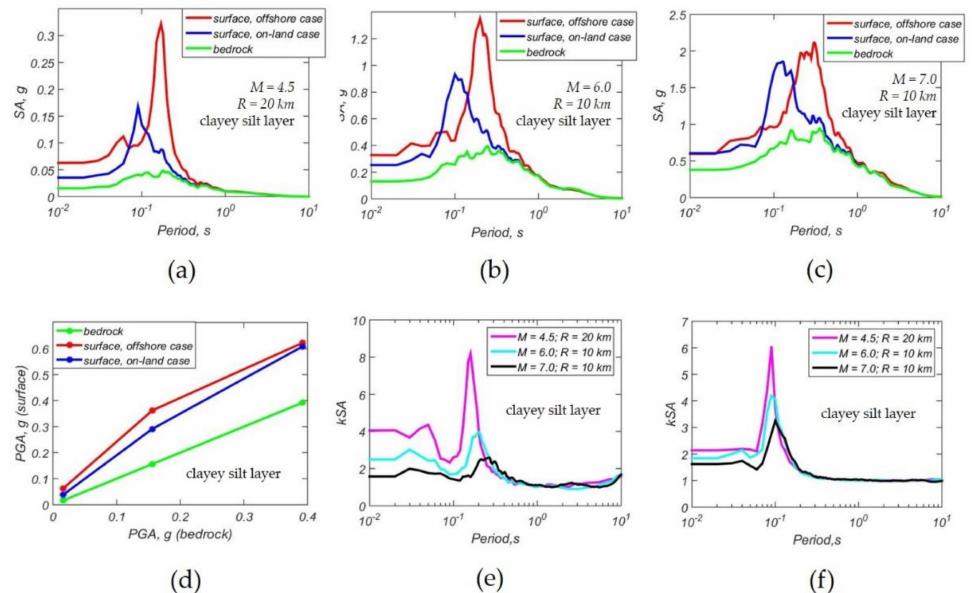
Figure 11. Modeling results for the case of clayey silt layer: ( a – c ) response spectral acceleration SA ( T , 5% ); ( d ) PGA values; ( e ) acceleration amplification curves for offshore case; ( f ) acceleration amplification curves for the onshore case.